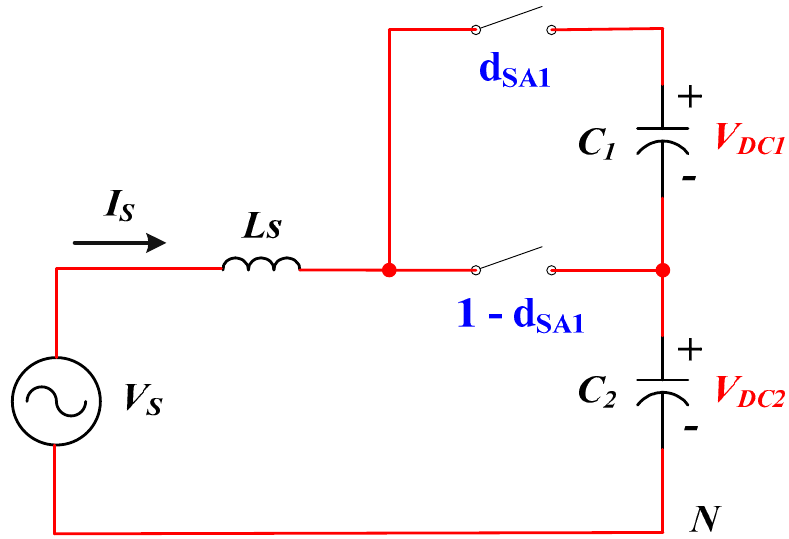
Figure 4. Simplified equivalent circuit of the OCC MV Regen-Load in region I.